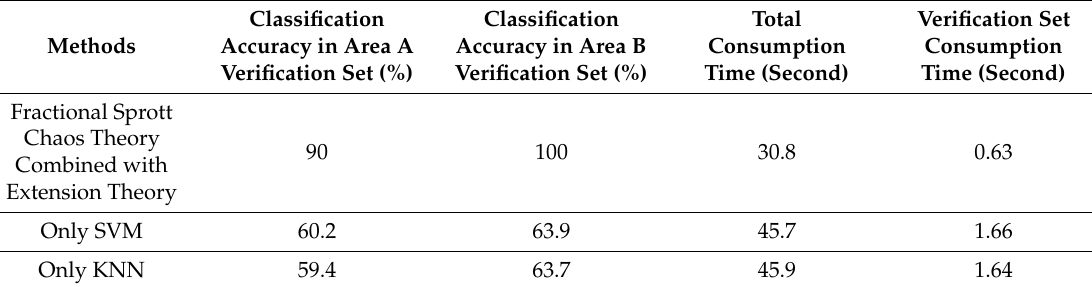
Table 7. Comparative analysis of classification